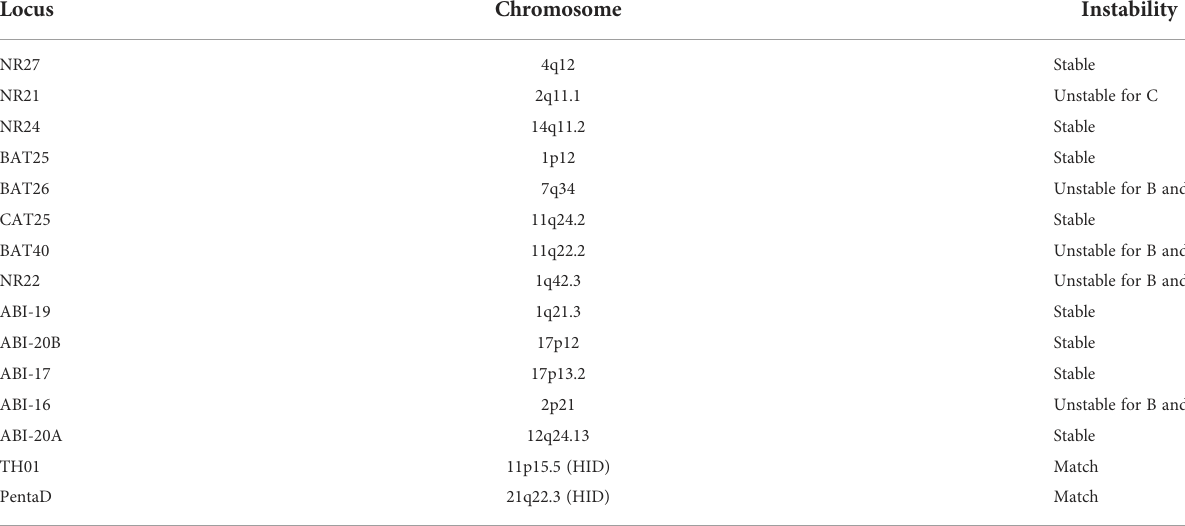
TABLE 2 MSI status associated with functional alteration of the mismatch repair system in patients B and C. Locus